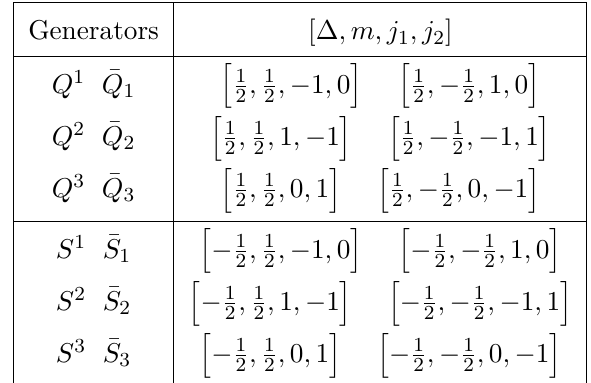
of the Cartan subalgebra i